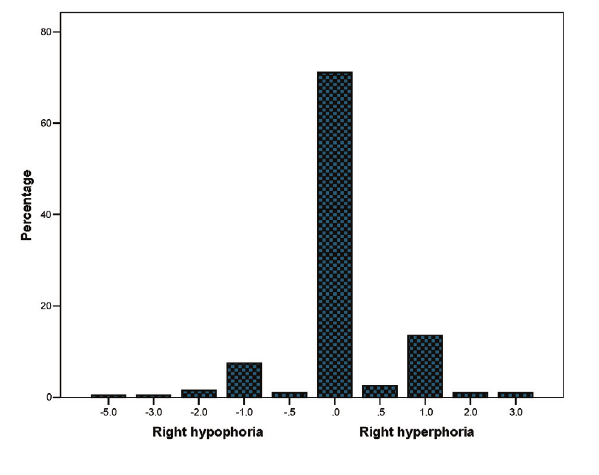
Figure 3 Distribution of vertical heterophoria for distance vision (total sample), showing a greater proportion of ortho- phoria. Also, the peak is at